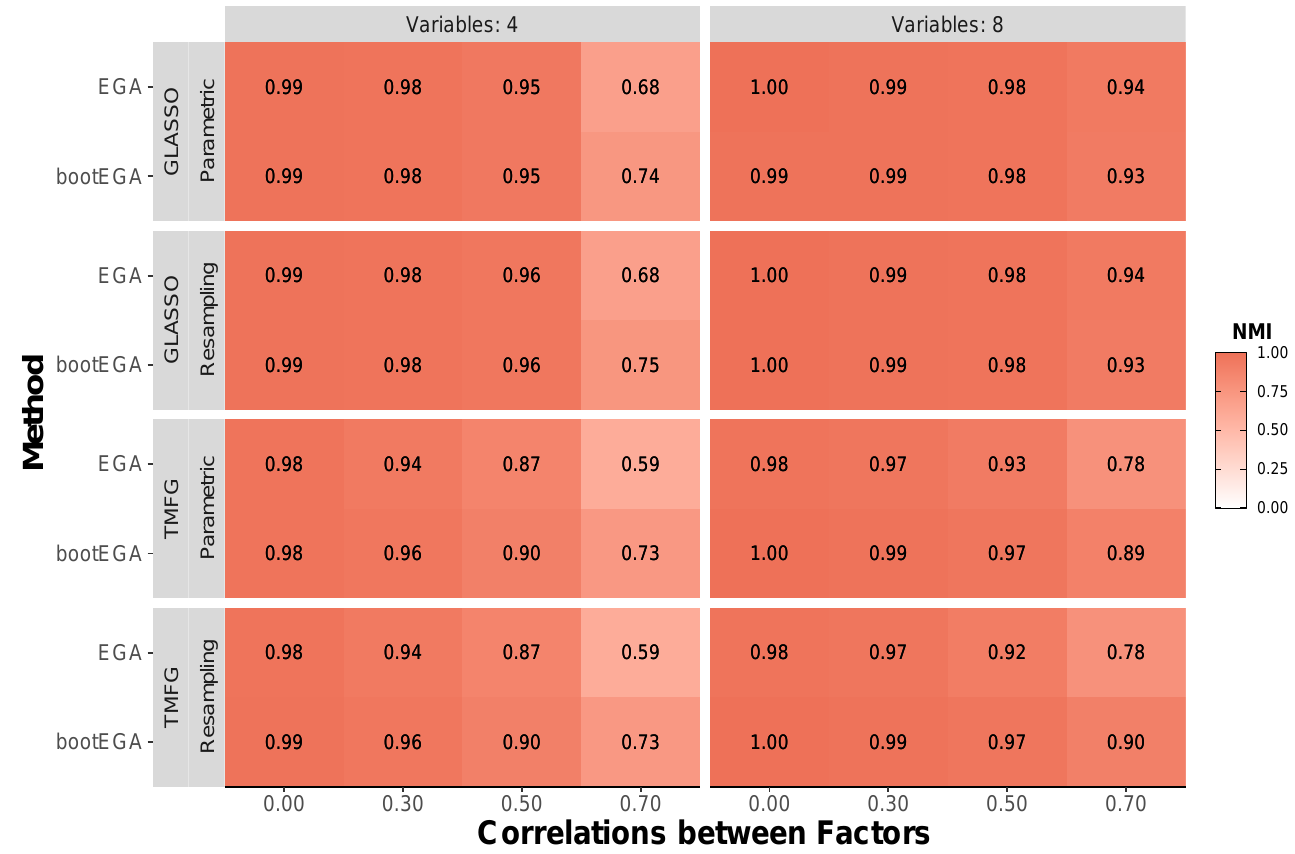
Figure 2. Normalized mutual information of the median bootEGA network structure and empirical